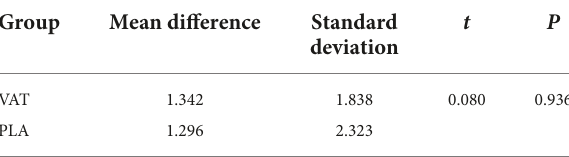
TABLE 7 Between groups difference for pre and post-test differences of VAS-M (VAS-M, visual analogue scale for muscle relaxation; VAT, vibroacoustic therapy; PLA: